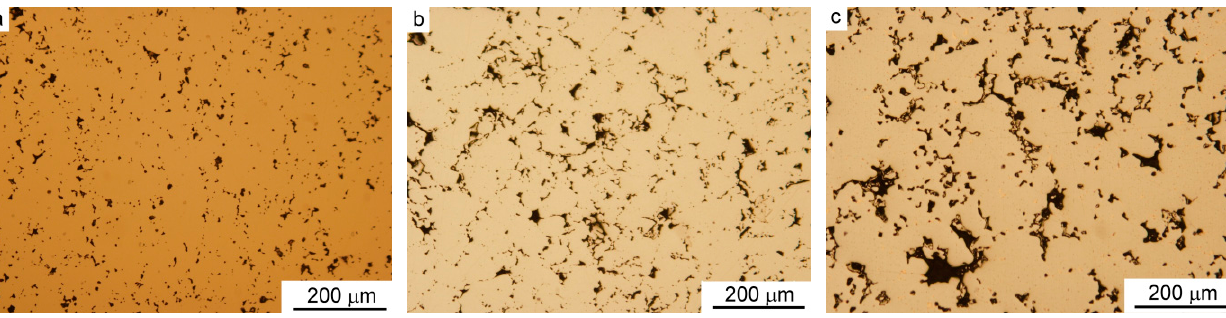
Figure 3. A typical microstructure of compacted copper-coated iron powders. The specimens pre- sented were fabricated by applying a pressure of 600 MPa on copper-coated iron powders contain- ing 3.2 wt.% Cu( a ) and 8.0 wt.% Cu ( b ), nital etched, LM.